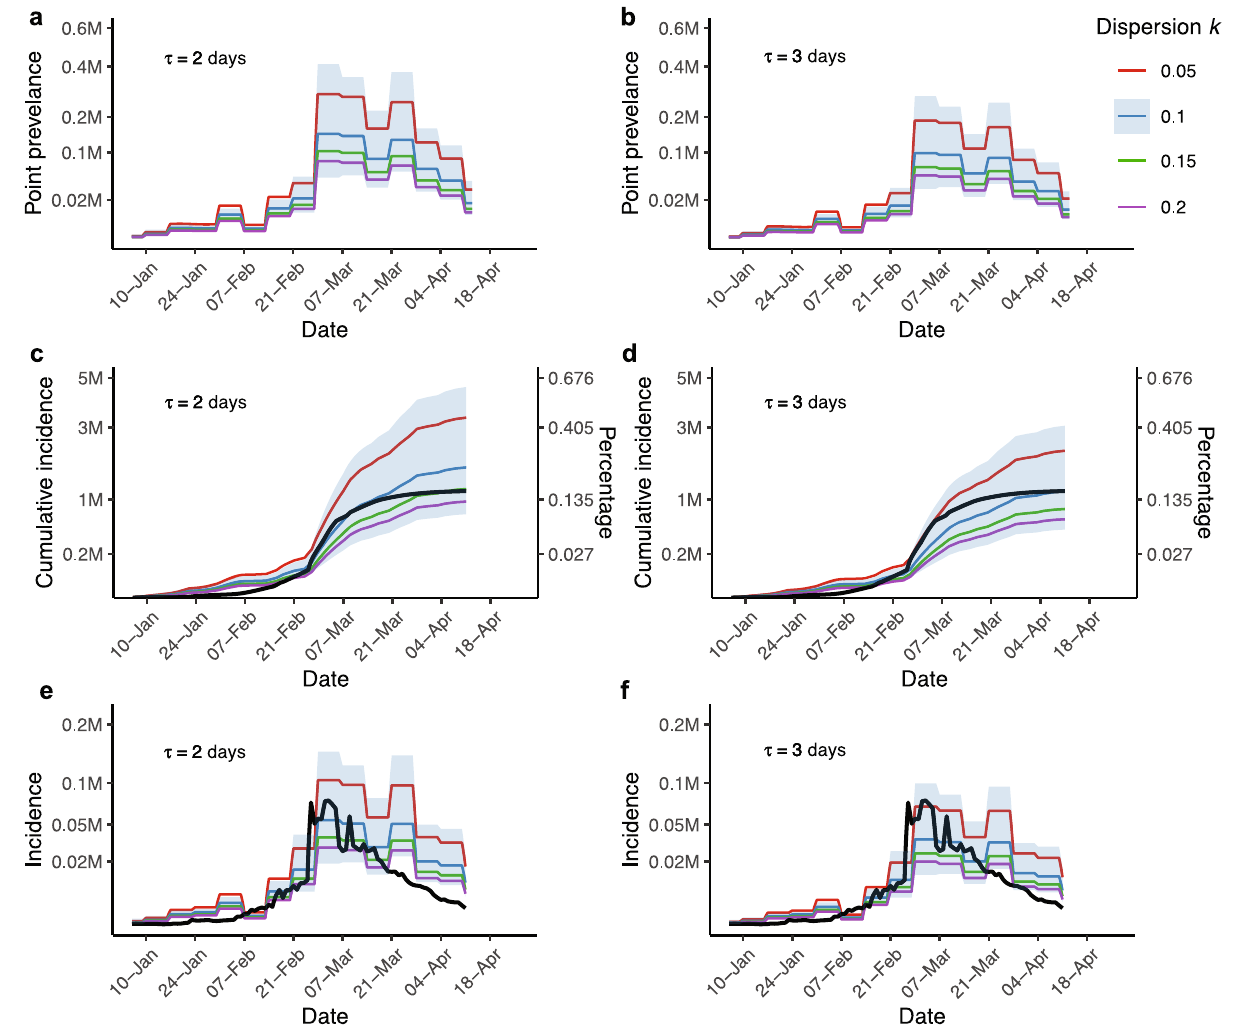
Fig. 4 | Estimations of point prevalence and cumulative incidence from 6 Jan- uaryto13April. Coloredlinesrepresentdifferentlevelsofdispersionparameter k . Point prevalence, cumulative incidence, and incidence are shown at generation time τ =2daysin a , c ,and e ,andat τ =3daysin b , d ,and f .Theblacklinesin c – f are